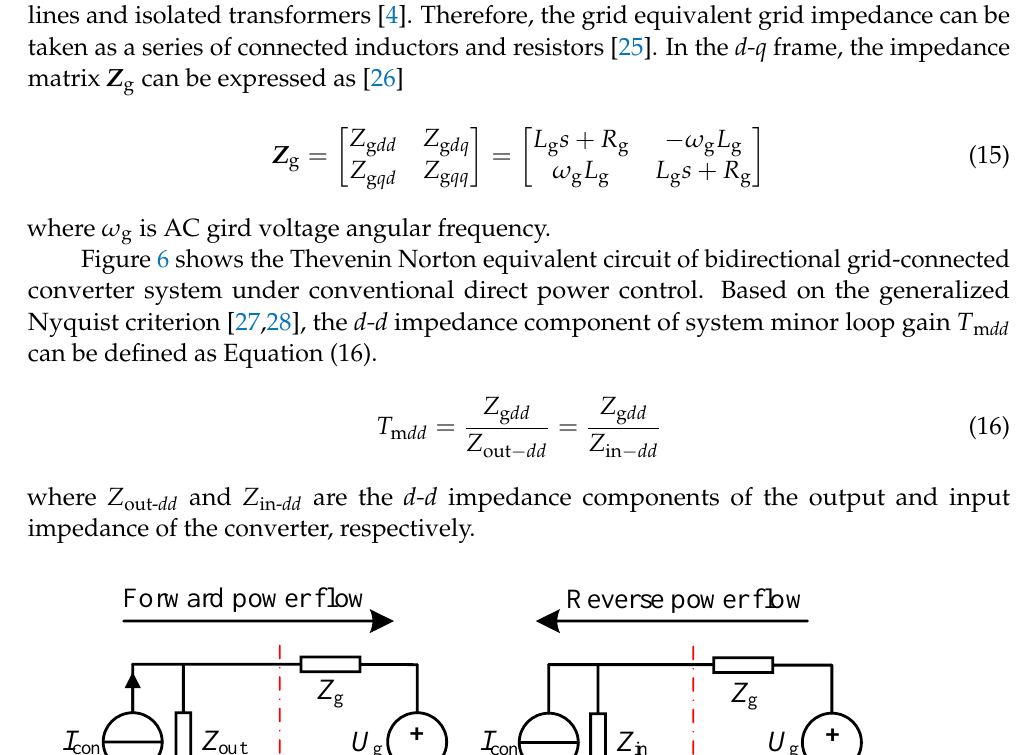
( b ) Figure 7. Nyquist plots obtained as power increases under conventional direct power control: ( a ) in the forward power direction and ( b ) in the reverse power direction. Firstly, comparing Figure 7a,b, at the low-power level, the gain margin (GM) in the forward power direction is larger than that in the reverse power direction. Moreover, at the high-power level, the Nyquist plots are noted to move away from ( −1 , j0) as the power increases when the power flows along the forward direction. That means the system can still remain stable under positive damping. However, the Nyquist plots, in the reverse